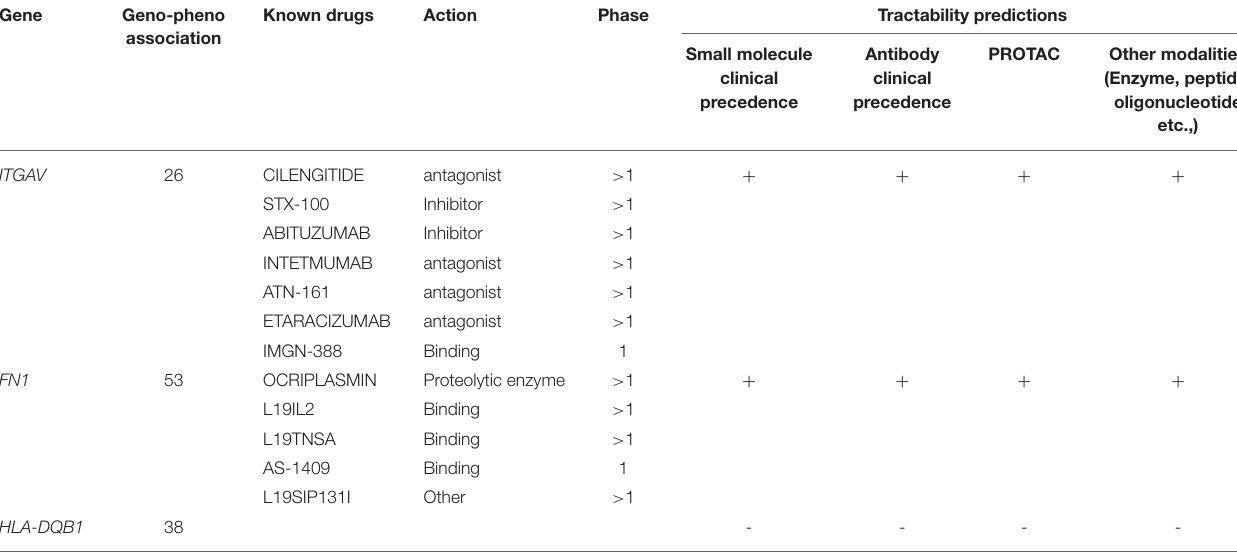
TABLE 2 | Open target platform for drug analysis. Gene Geno-pheno